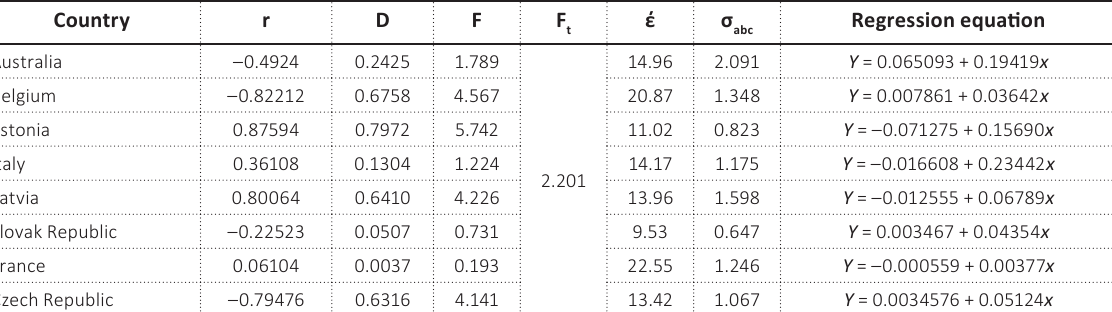
Table 2. Impact of interest rate (x) on the share of outstanding loans of SMEs in the overall structure of outstanding loans ( Y ) by individual countries